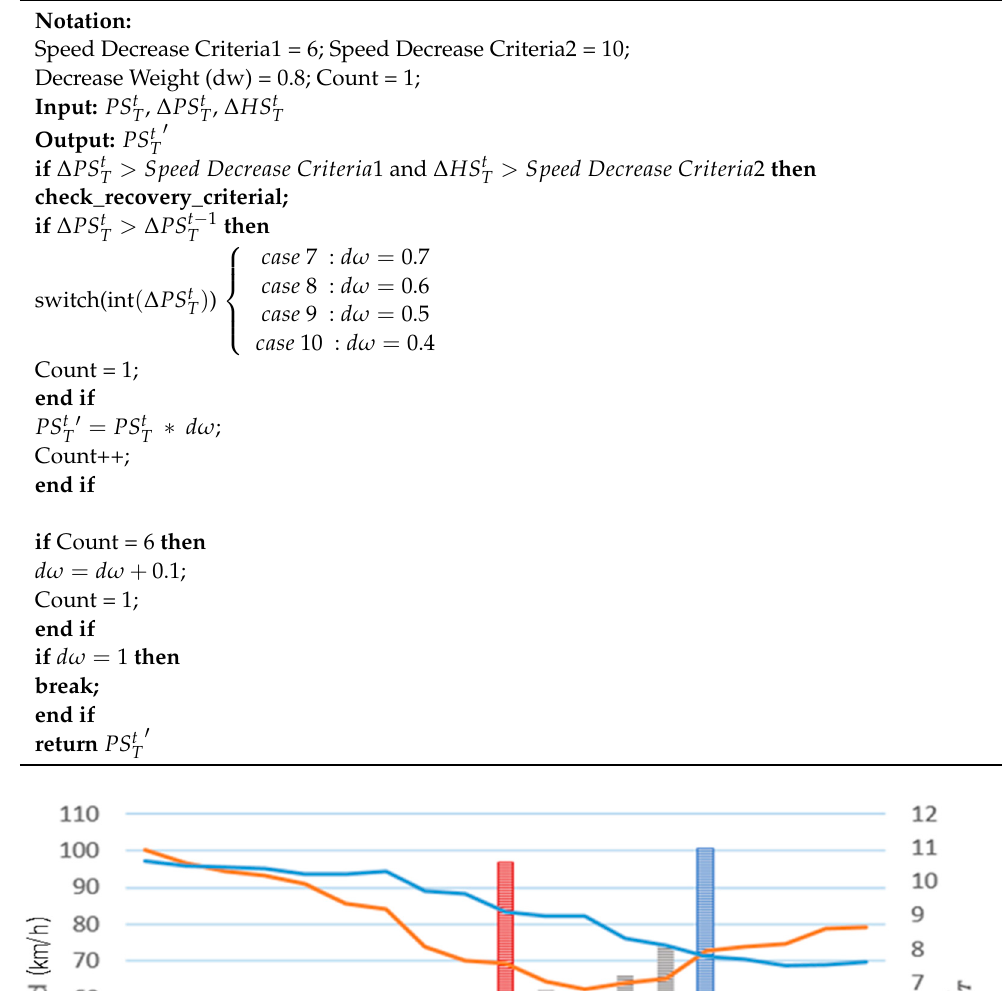
Algorithm 1: Event Weighting Algorithm (Decrease Section)